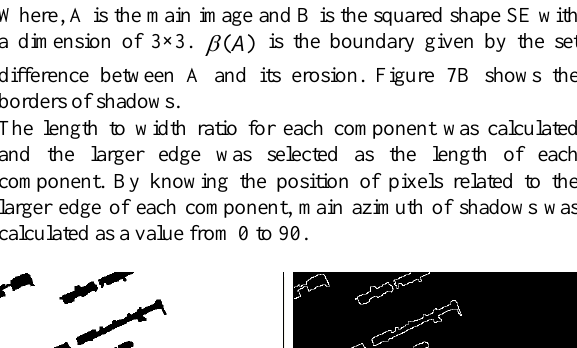
Figure 8. A. Subtracting main image from shadow-free image, B. Opening and closing operators were performed on (A) to